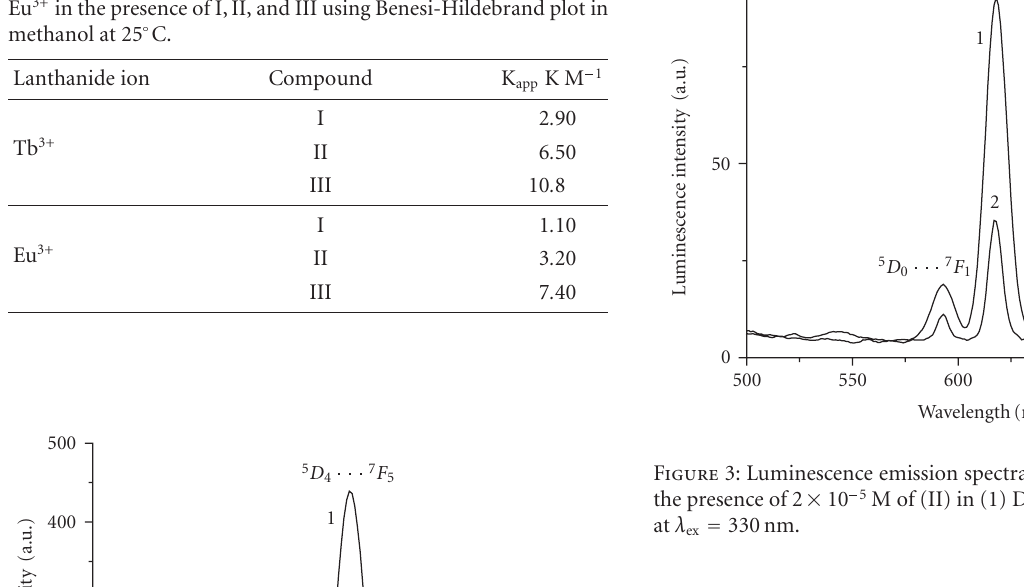
10 (cid:0) 5 M of Eu 3+ in (cid:0)